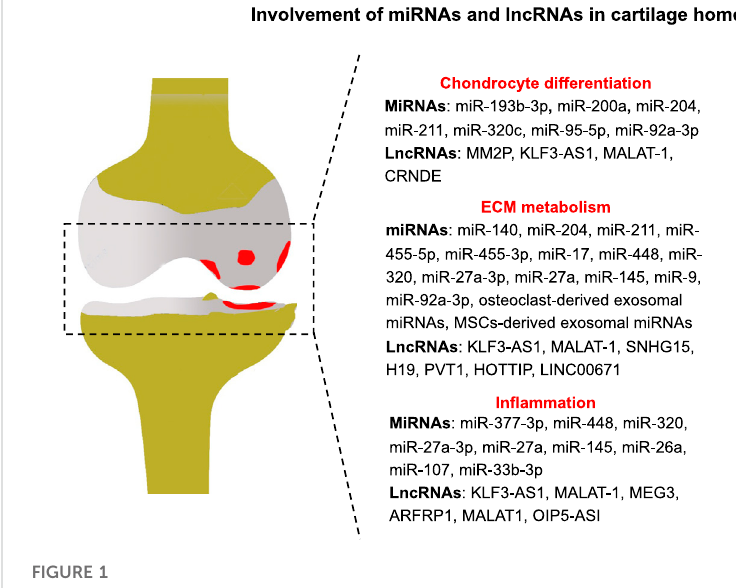
FIGURE 1 Involvement of miRNAs and lncRNAs in cartilage homeostasis and OA